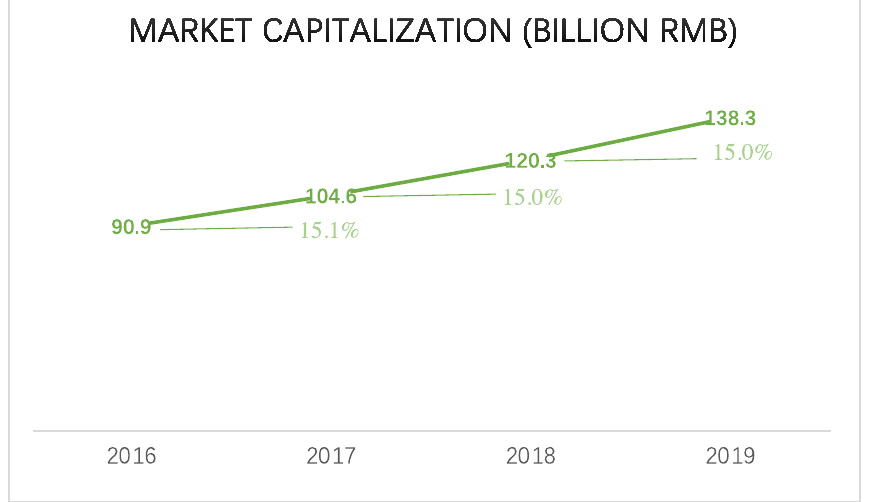
Figure 2. Equestrian market (billion RMB), data from [19].